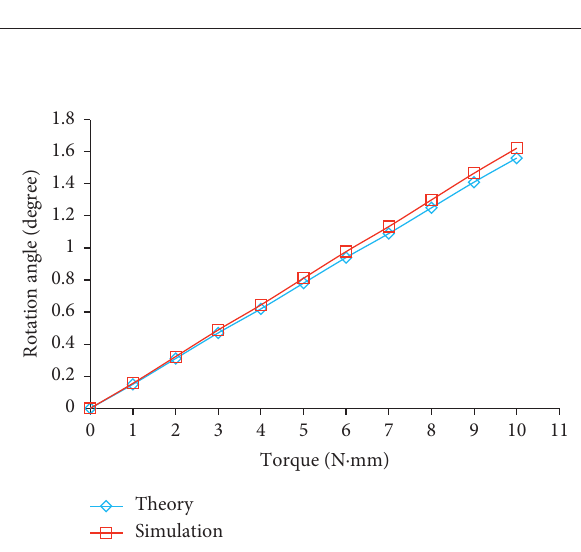
Figure 7: Comparison of the rotation angles between the theory and